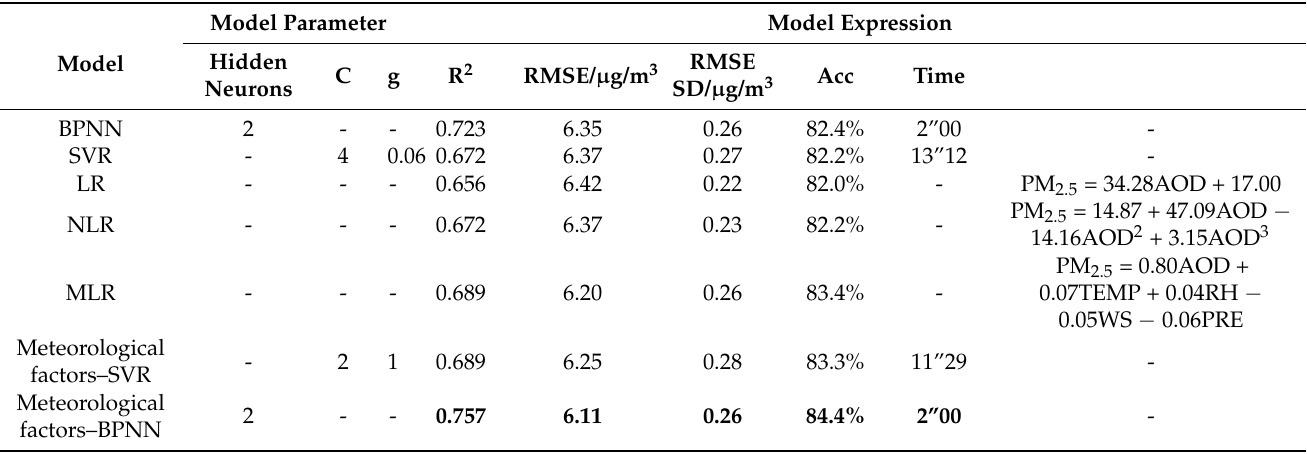
Table 7. Comparison of model parameters and